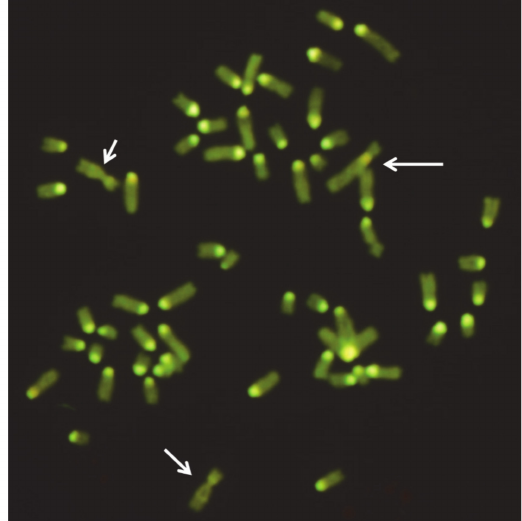
Figure 7. Female cattle metaphase treated for CBA banding in a heterozygous carrier of rob(1;29) (2 n = 59,XX). Note the single C-band block in the rob(1;29), especially present on the q arms (large arrow). Small arrows indicate X